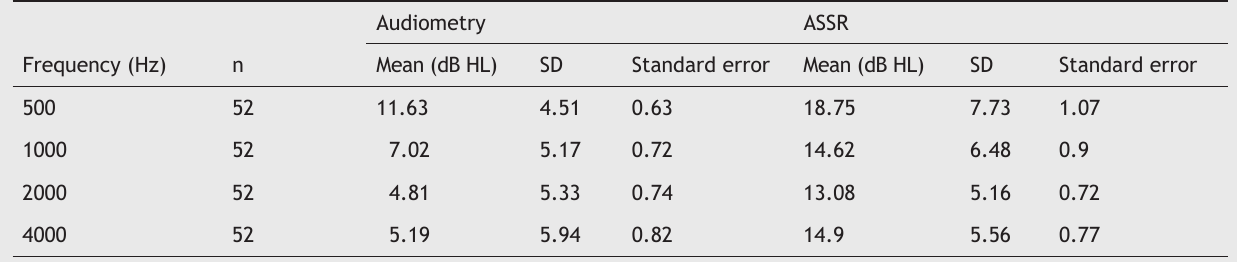
Table 1 Mean audiometric thresholds and steady-state responses (n = 52 ears) for each frequency with standard deviation (SD) and standard error.